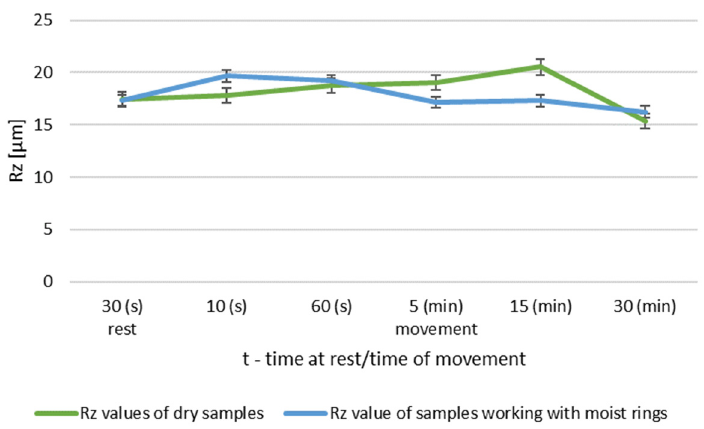
Figure 13. Comparison of Rz values of dry and wet ring samples for group III roughness.